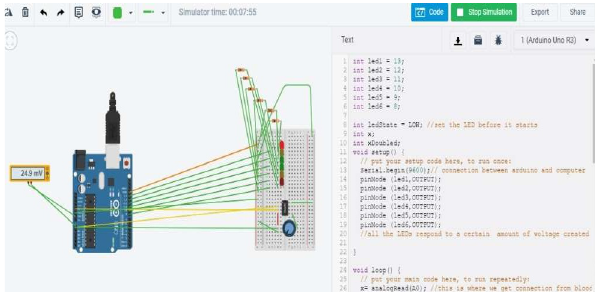
Fig: When Glucose level is very high, the LED 1 (red)